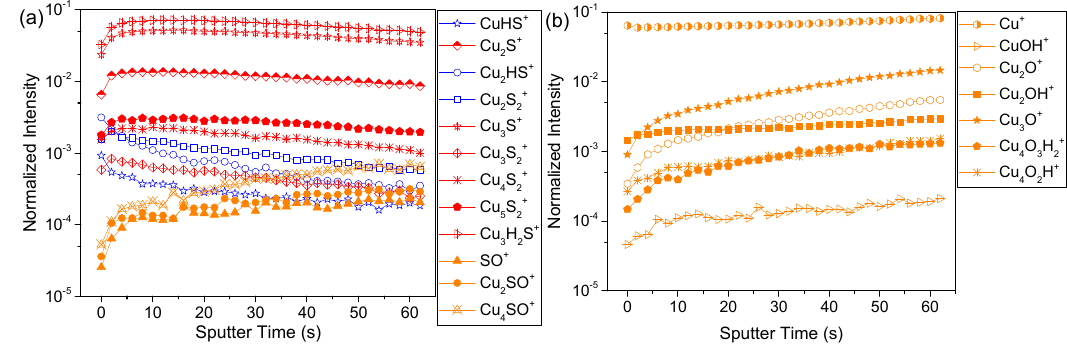
Figure 5. The depth profile curves for positive ions of sulfidized malachite: ( a ) sulfur containing positive fragment ions and ( b ) oxygen ‐ containing positive ion and Cu + fragments.